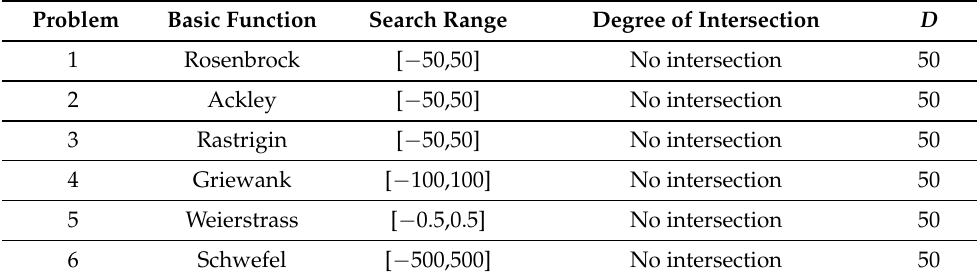
Table 2. Description of the six MTO problem sets in test suite